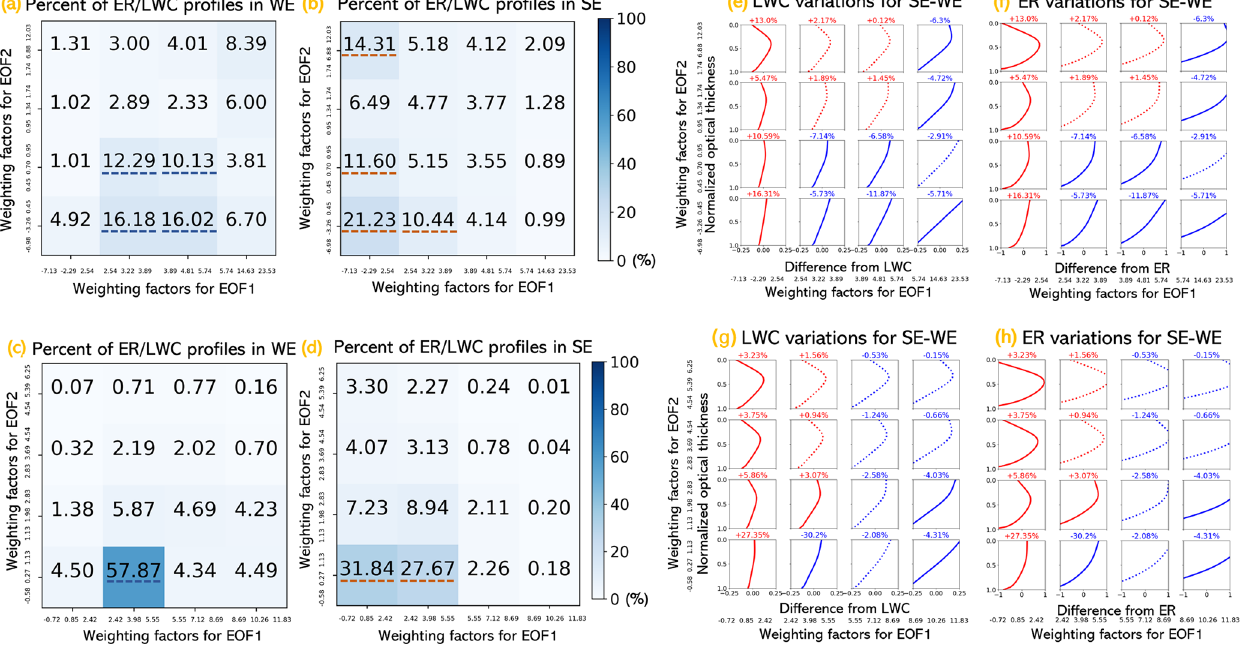
Figure 7. (a) The percent of profiles for weak cloud-top entrainment (WE); the bins are characterized by quartile boundaries. (b) Same as (a) but for strong cloud-top entrainment (SE). (c) The percent of profiles for weak cloud-top entrainment (WE); the bins are characterized by arithmetic mean boundaries. (d) Same as (c) but for strong cloud-top entrainment (SE). These boxes that received more than 10% of the examples are underlined by a dotted blue line for WE cases and by a dotted tangerine one for SE cases. Panels (e) and (f) show the difference between the percent of samples for LWC and ER between SE (b) and WE (a) cases; (g) and (h) show the difference between the percent of samples for LWC and ER between SE (d) and WE (c) cases. In (e) – (h) , red color and blue color indicate the increase and decrease in the samples; small variations in percent (within ± 3%) are plotted with a dotted